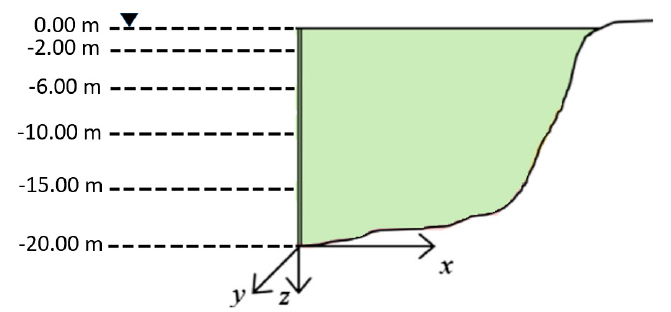
Figure 5. Performed water levels.